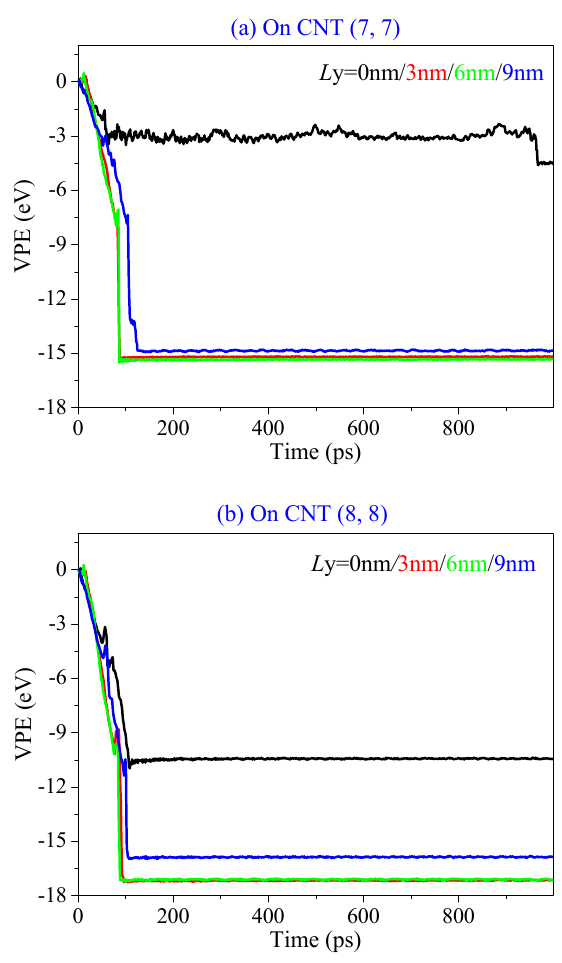
Figure 6. Historical curves of VPE of the BP during winding upon CNT with α = − 30 ◦ , but different values of L y. ( a ) On CNT (7, 7). ( b ) On CNT (8, 8). When moving the oblique CNT (8, 8) from left to right ( L y = 0, 3, 6, 9 nm), the self-assembly processes of the ribbon are illustrated by the snapshots of the BP during winding upon CNT between